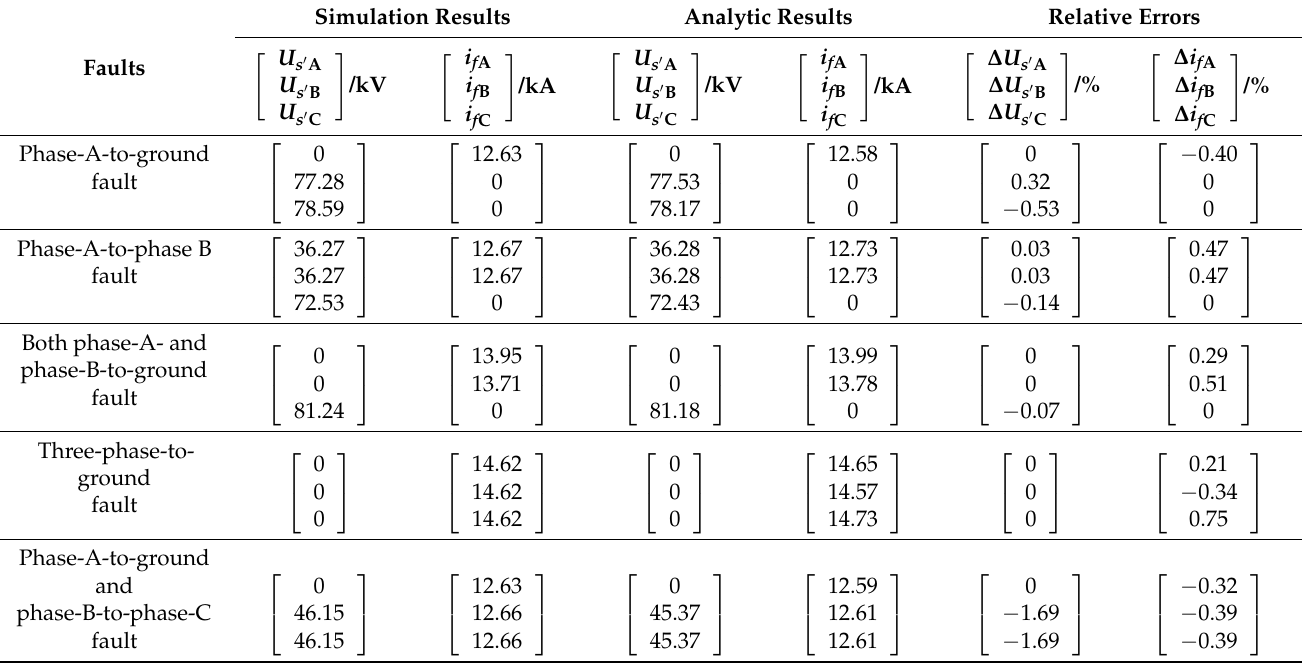
Table 3. The comparison of fault analysis between analytic and simulated studies for different short-circuit faults. Simulation Results Analytic Results Relative Errors Faults